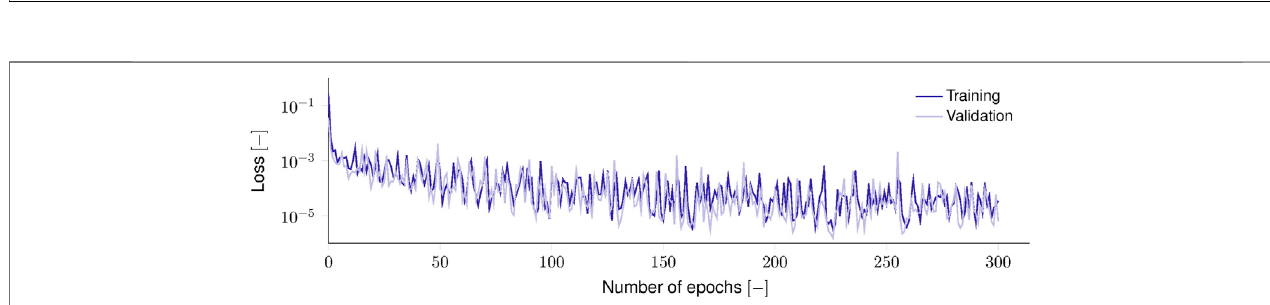
FIGURE 10 | An explainable elastoplastic constitutive model. (A) The strain-driven loading over the time increments. (B) The stress response of the reference and data-driven constitutive model. (C) The plastic strain, compared to the three major principal components of the cell state. The cell states approximate the plastic strain (with a negative sign remedied by the output layer).